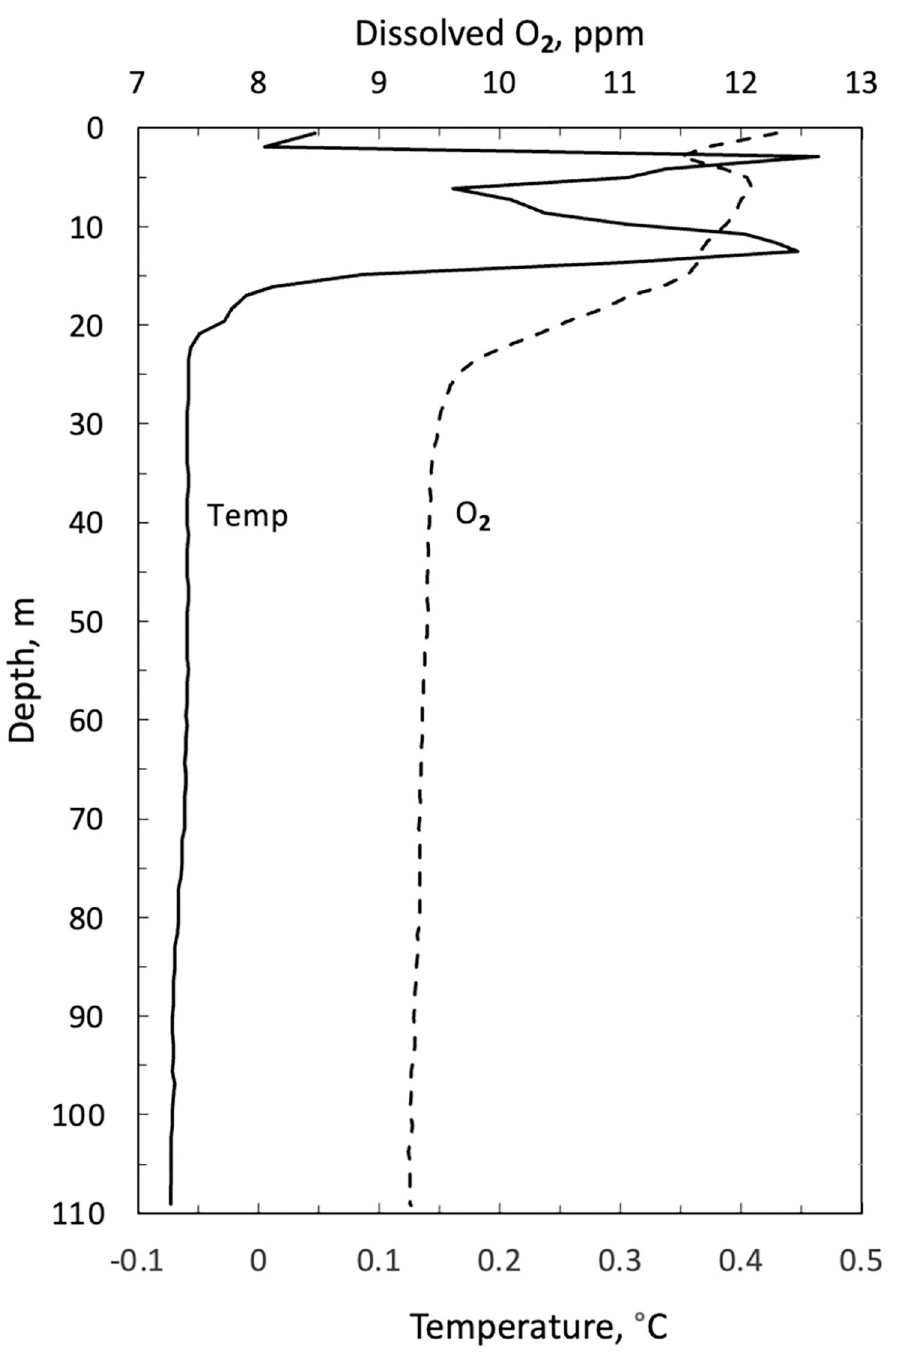
Fig 6. Profile of temperature and dissolved oxygen in Astro Lake on 7 July